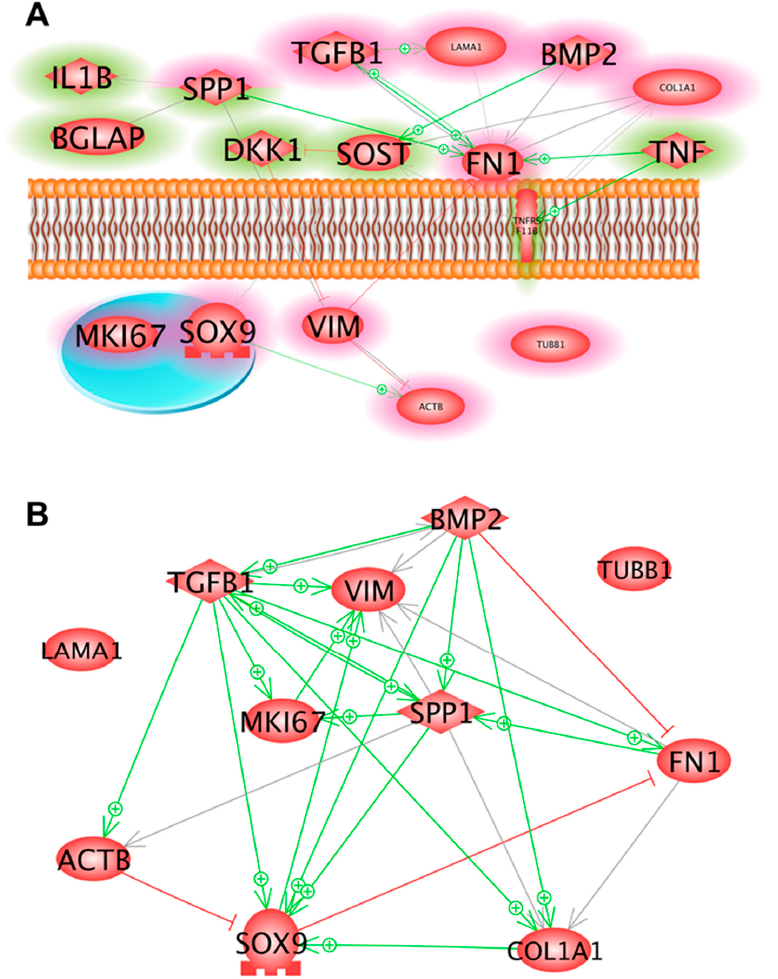
Figure 7. ( A ) Interaction and localization of proteins detected either in the supernatant by Luminex technology (green rims) or within the cells by Western blotting (red rims). Solid lines indicate binding, solid arrows show directed interaction and dashed arrows show influence. + signs point to an activity enhancing effect and red lines indicate inhibition. ( B ) Mutual interactions of the expression of the genes, investigated by qRT-PCR and shown in Figures 3I–K, 4E–H, 5A–D and in Table 1. + signs point to an activity-enhancing effect and red lines indicate inhibition. Each interaction network was built using Pathway Studio v.11.